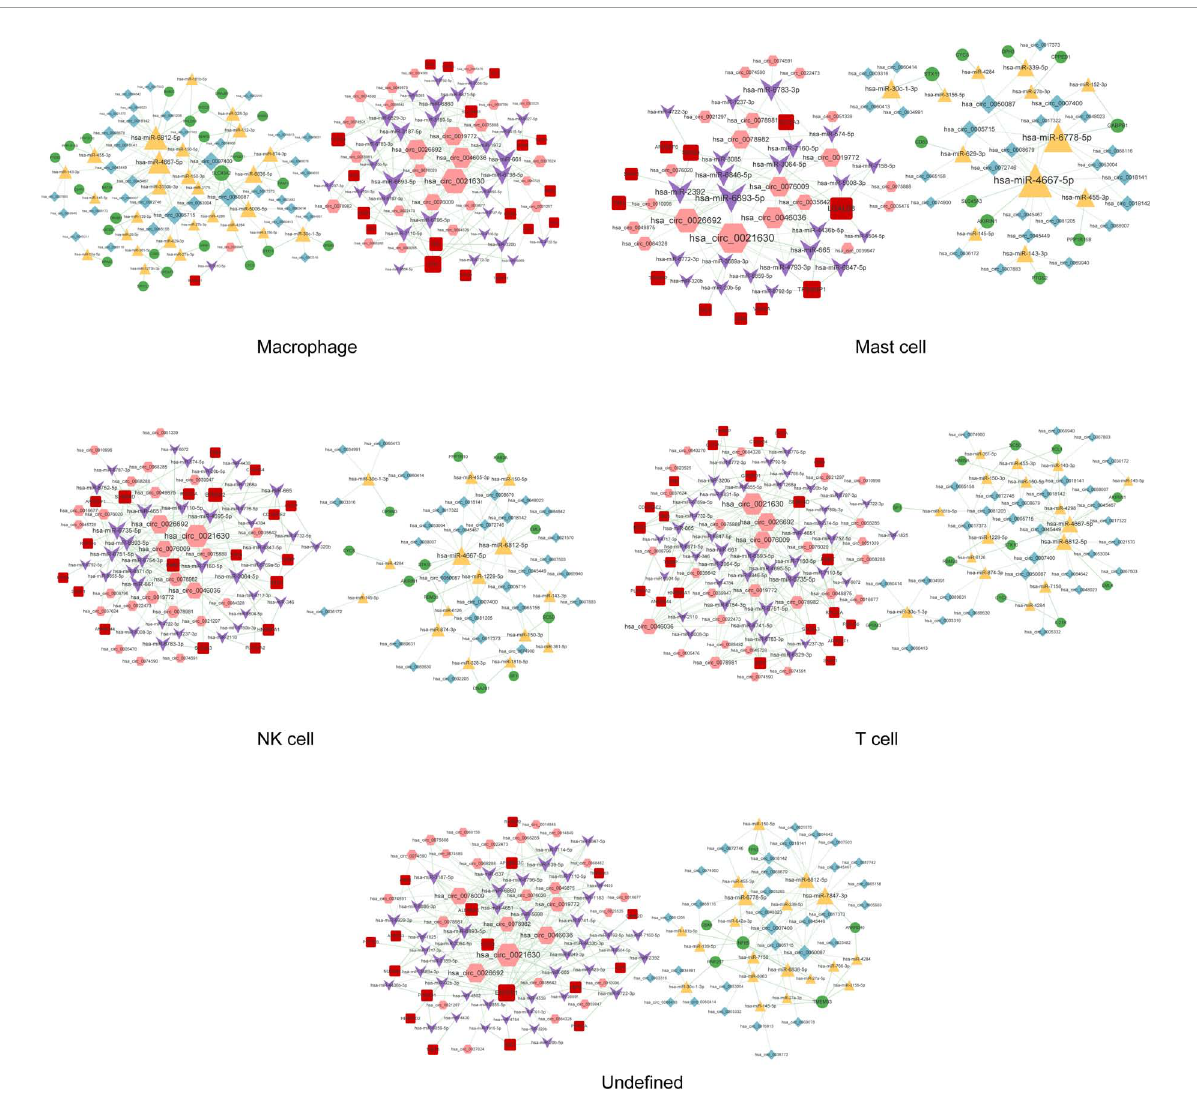
FIGURE7 The circRNA–miRNA–mRNA regulatory network in macrophages, mast cells, NK cells, T cells, and undefined cells. Red squares represent upregulated mRNAs; green circles represent downregulated mRNAs; yellow triangles represent upregulated miRNAs; purple arrows represent downregulated miRNAs; pink hexagons represent upregulated circRNAs; blue rhombuses represent downregulated circRNAs; dotted lines indicate competitive binding of circRNAs to miRNA; solid lines indicate regulation of mRNAs by miRNAs. The node size represents the degree of